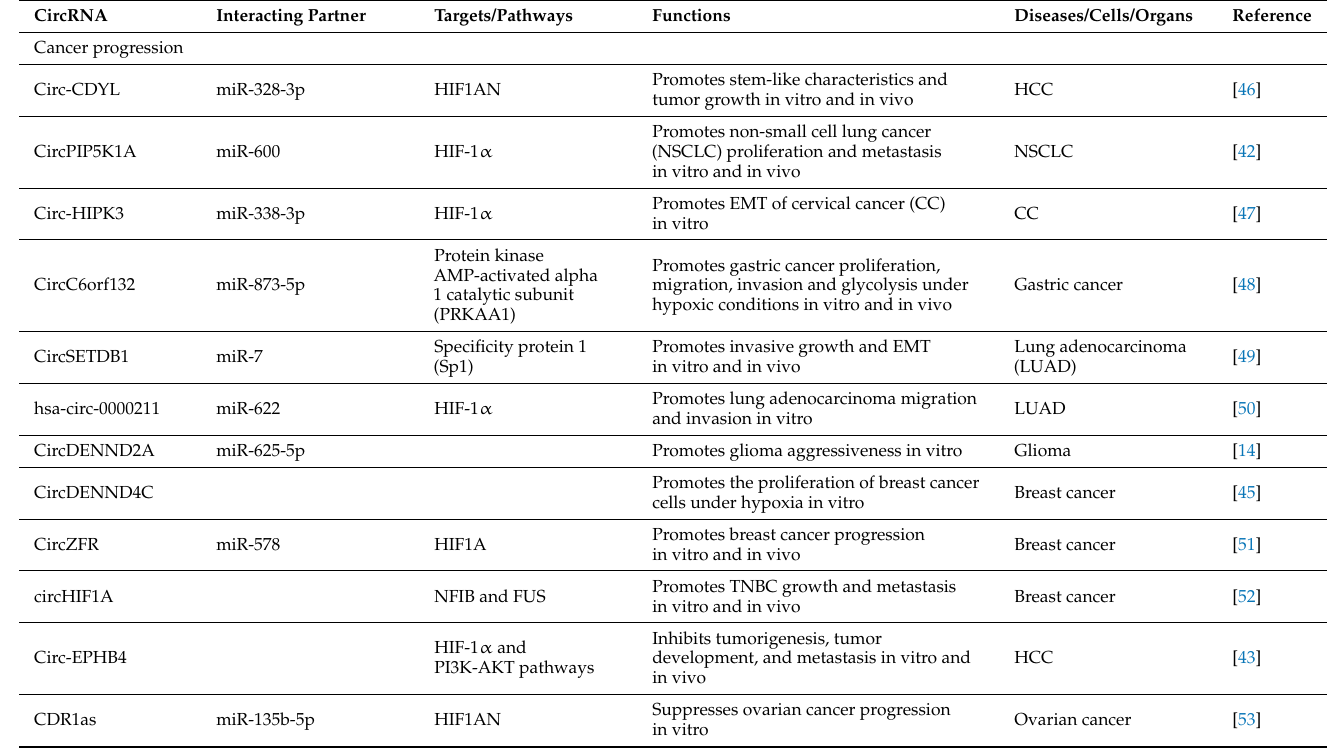
Table 1. Summary of the circRNAs related to the hypoxic